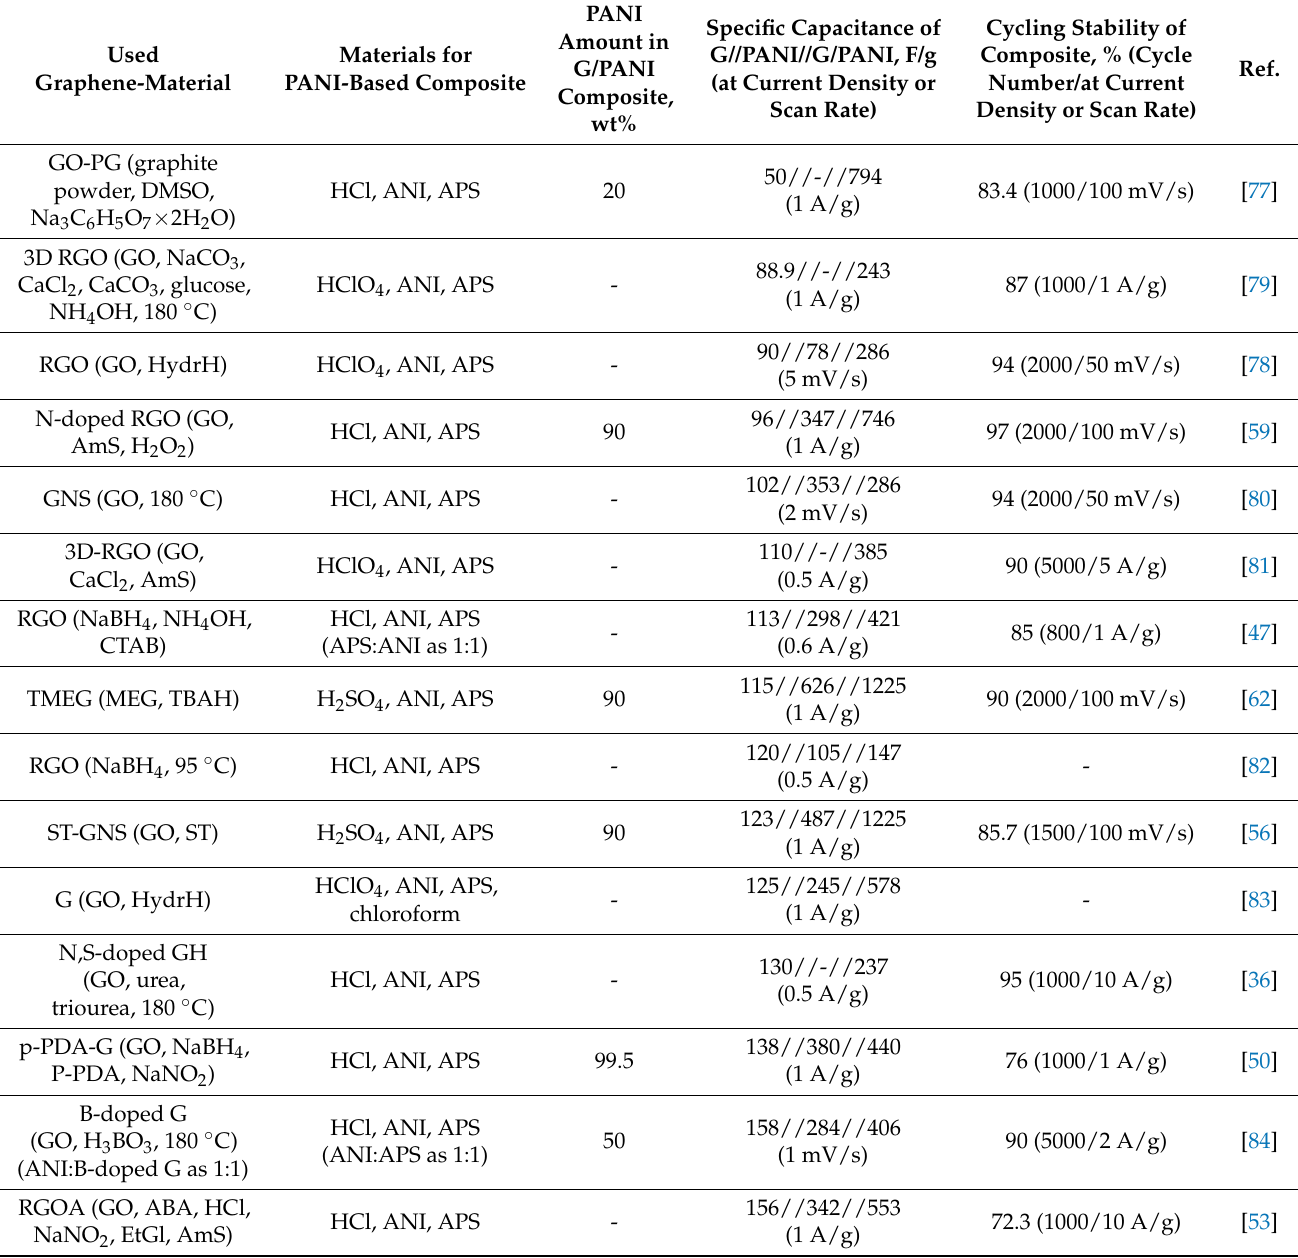
Table 2. Literature data for graphene-related component separately and in graphene/PANI composite measured in three-electrode systems (ordered by the values of the specific capacitance of